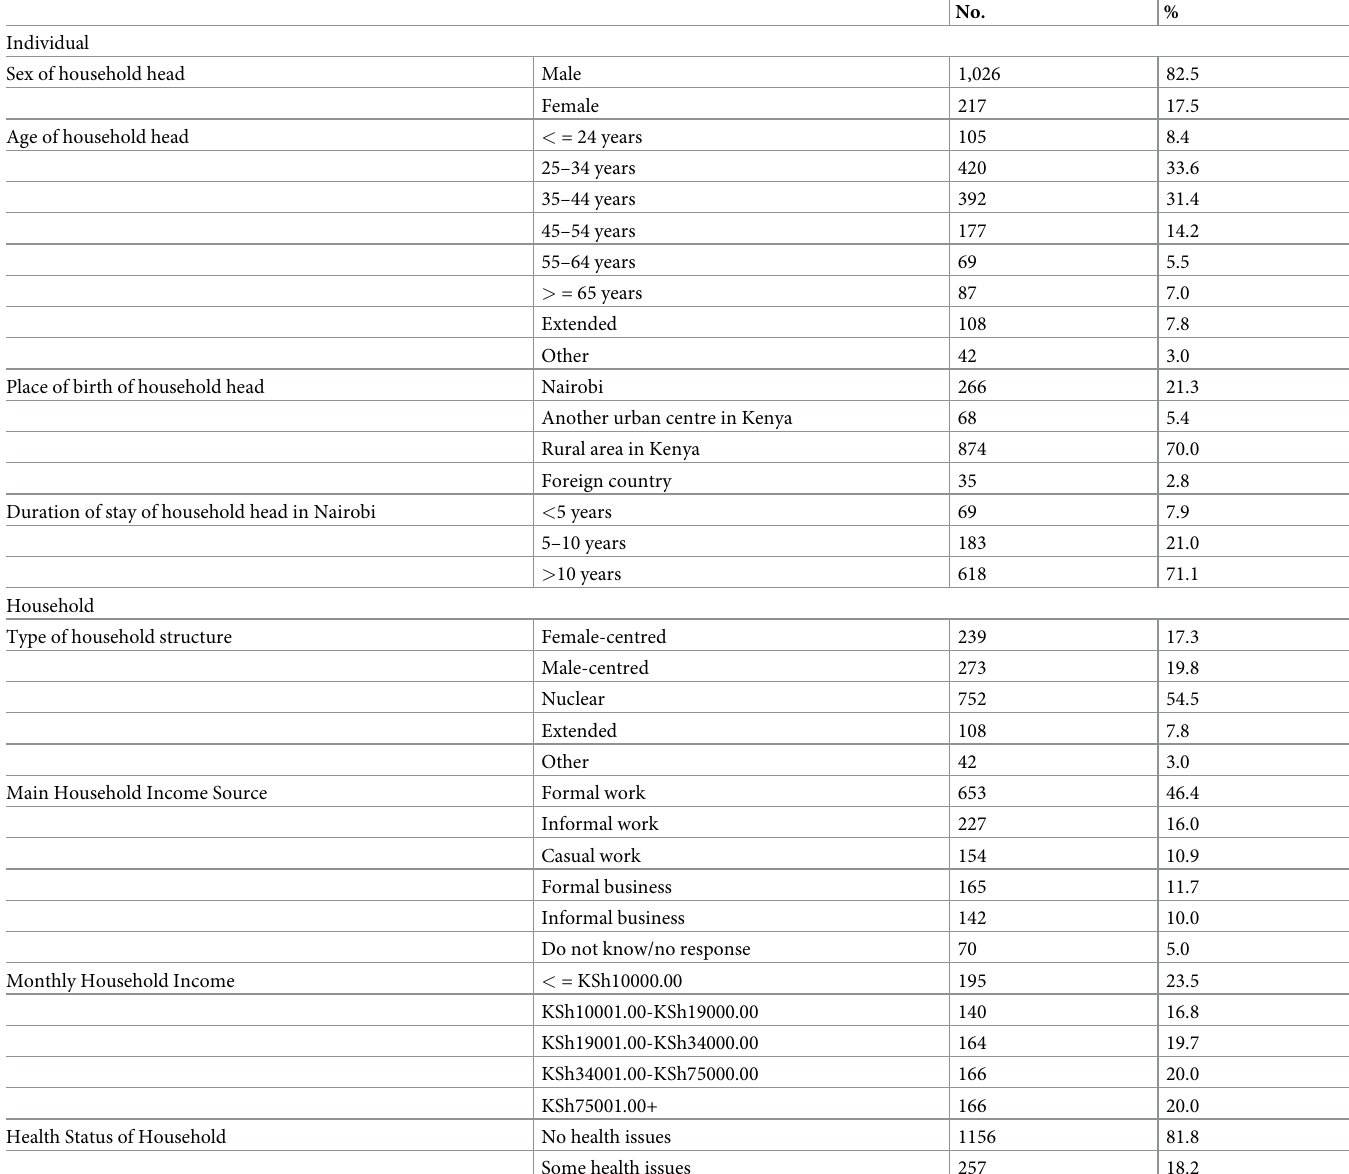
Table 2. Nairobi household demographic and economic